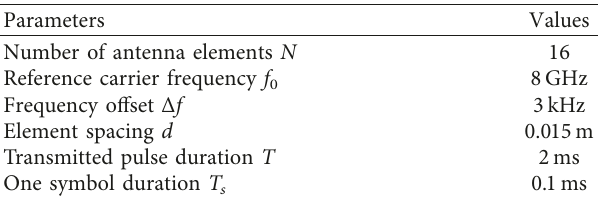
Table 1: Parameters for linear antenna element IM FDA